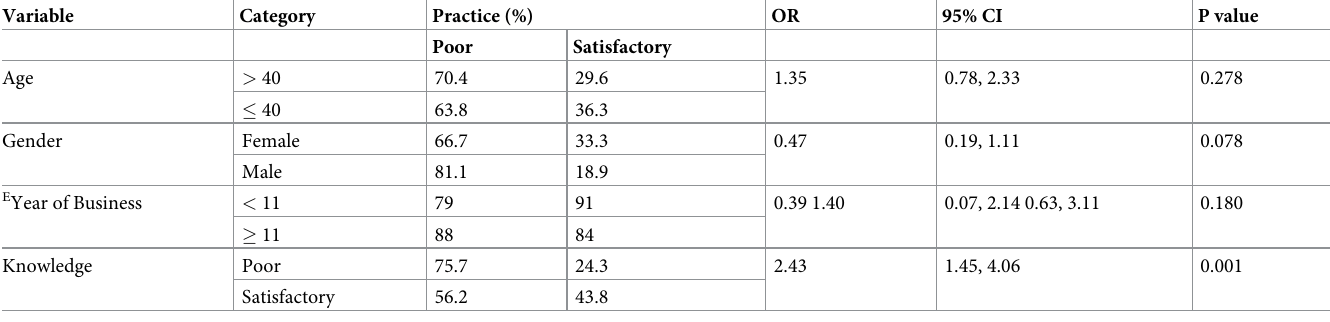
Table 5. Association between demographic characteristics and practice of respondents on antibiotic residues. Variable